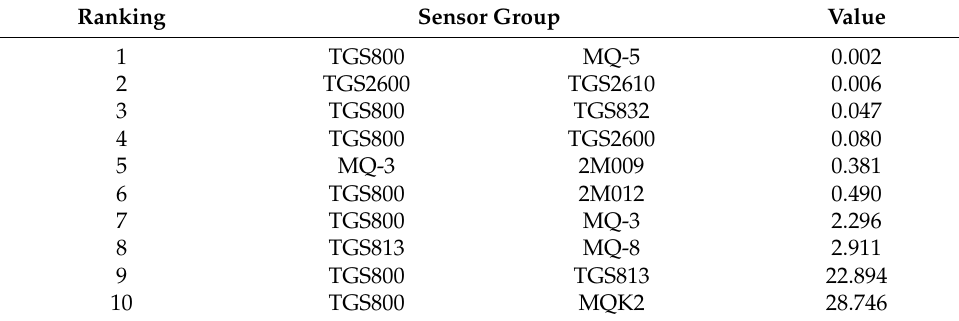
Figure 7. Icicle figure of clustering sensors’ response average value (6 kinds of green tea). Table 6. Clustering coefficient among